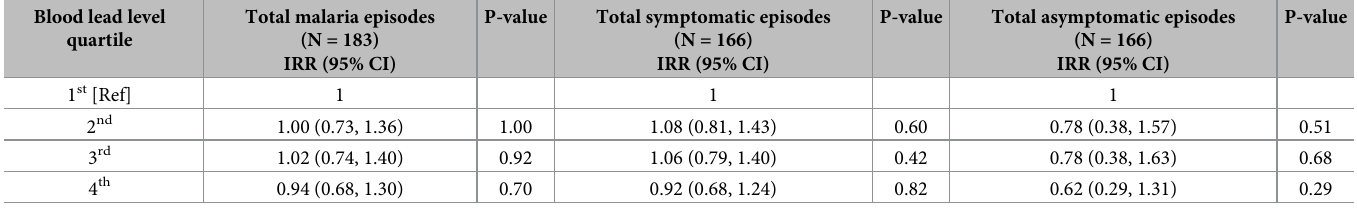
Table 4. Multivariate negative binomial regression models for associations between blood lead level quartile and malaria outcomes † . Blood lead level